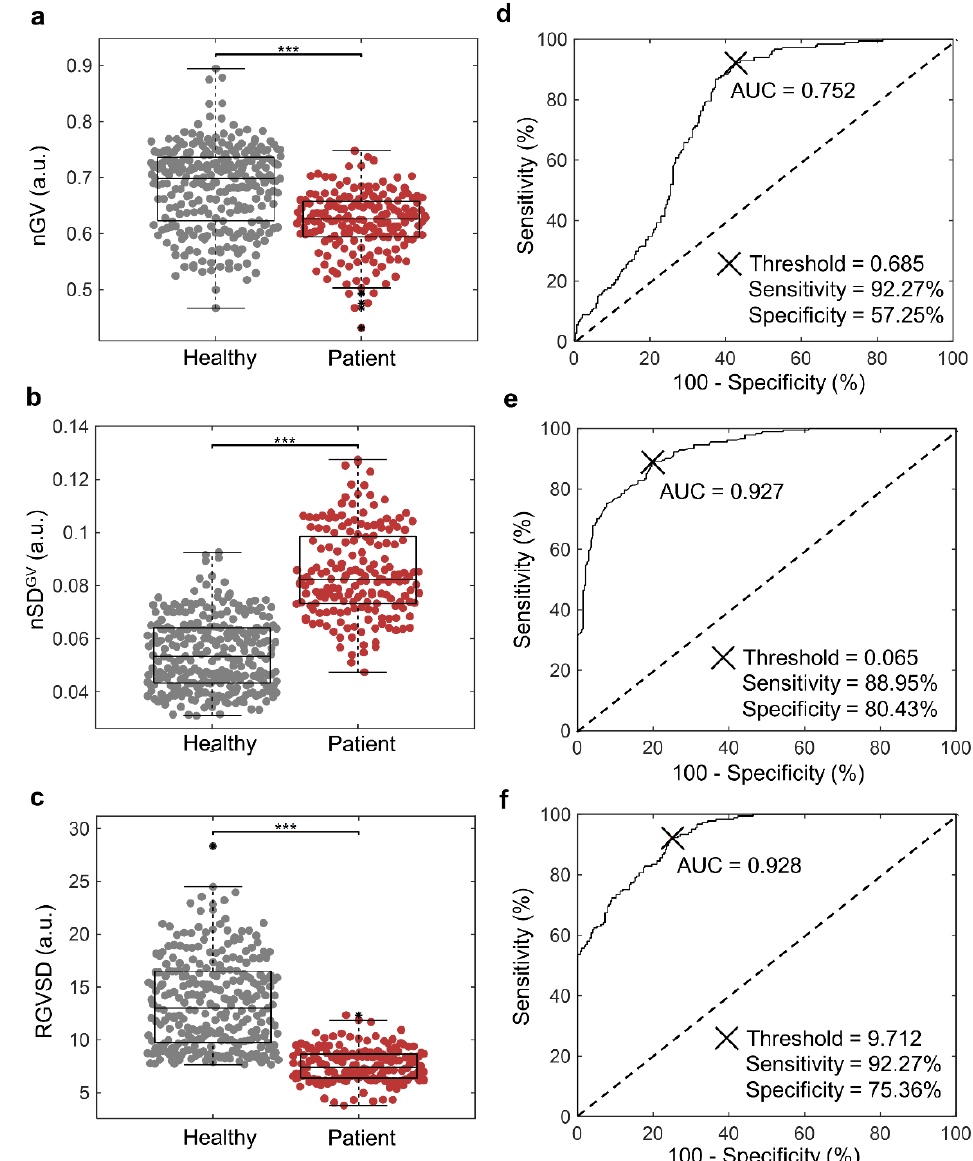
Figure 4. Patient stratification of healthy and cancer patients with LIQBP. ( a ), ( b ), and ( c ): Boxplots illustrating correlation analysis of nGV (0.68 ± 0.07 and 0.62 ± 0.05), nSDGV (0.054 ± 0.013 and 0.085 ± 0.017) and RGVSD (13.50 ± 4.22 and 7.60 ± 1.57) for healthy and patient cohorts, respectively. *** Represents p ≤ 0.001. ( d ), ( e ), and ( f ): Corresponding ROC analysis for ( a ), ( b ) and ( c ), respectively. The resultant AUC, threshold, sensitivity, and specificity analyses are as shown in the